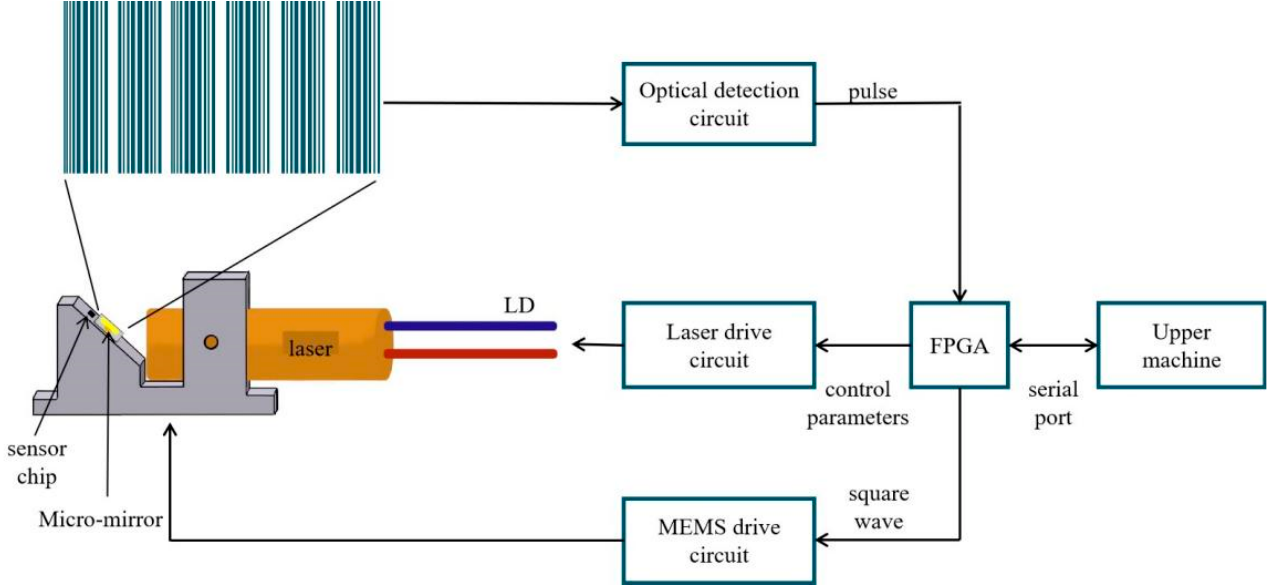
Figure 1. The architecture of the structure light system.